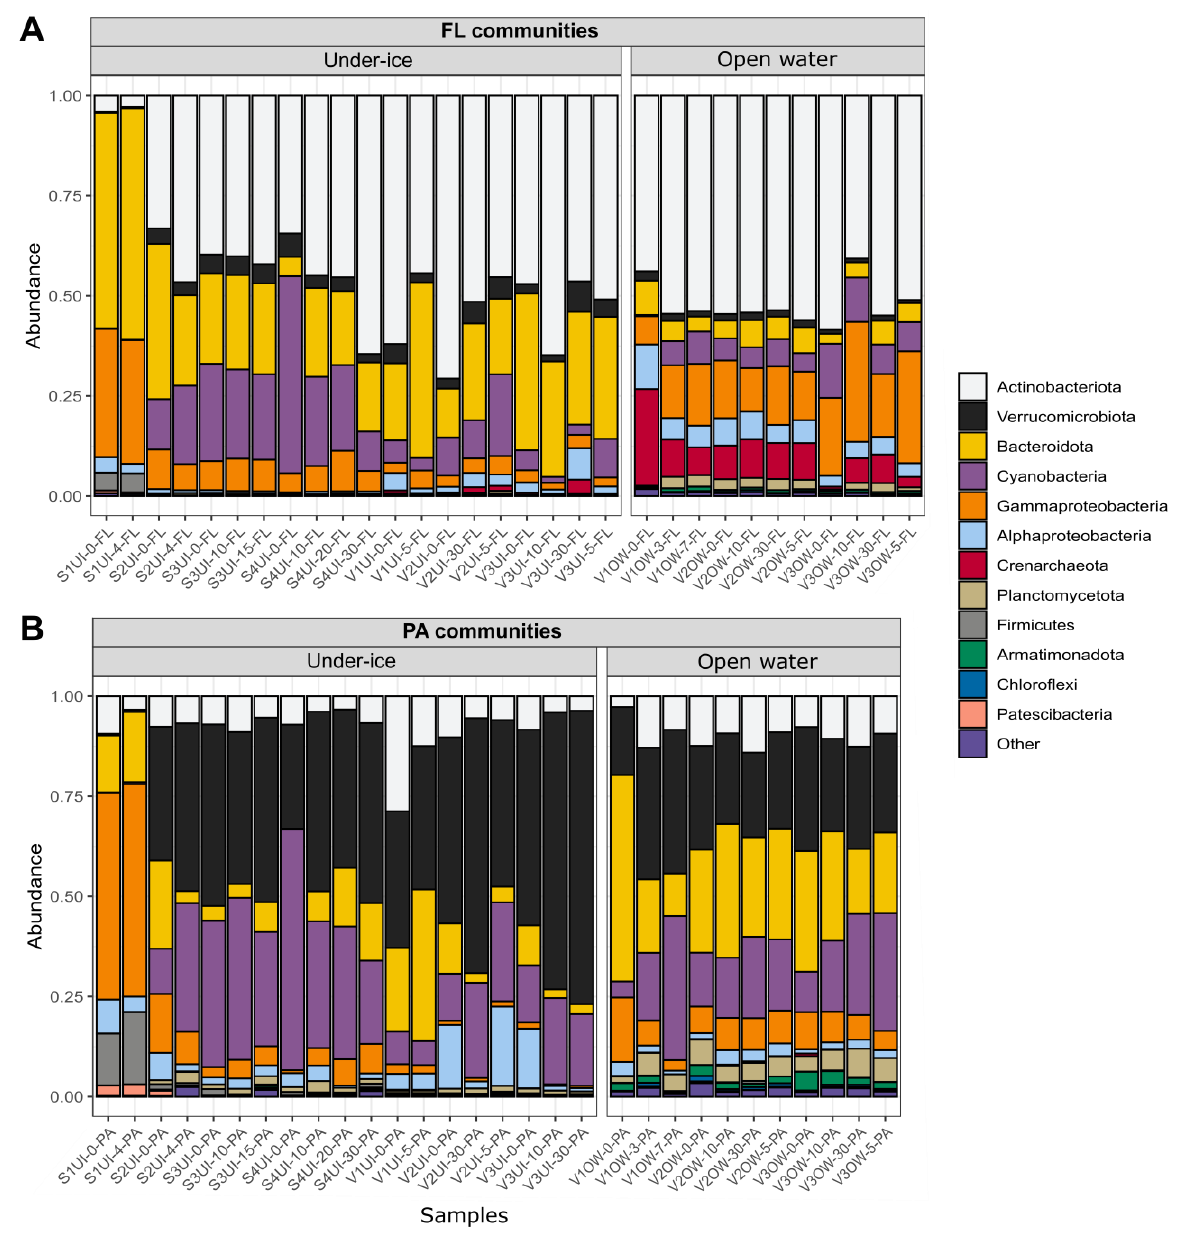
Figure 8. Relative abundances of the top-12 bacterial phylotypes in FL ( A ) and PA communities ( B ). Phylotypes are shown at the phylum level, except for Proteobacteria , which are shown at the class level. The bar stacks are arranged into four facets by two factor variables: “Lifestyle“ and “Period”. The profiles are horizontally sorted by sampling site, month and sampling depth. Taxa presented in the color legend are sorted by total abundance in the decreasing order, except the last category “Other”. The order of phylotypes in each bar is the same as in the color